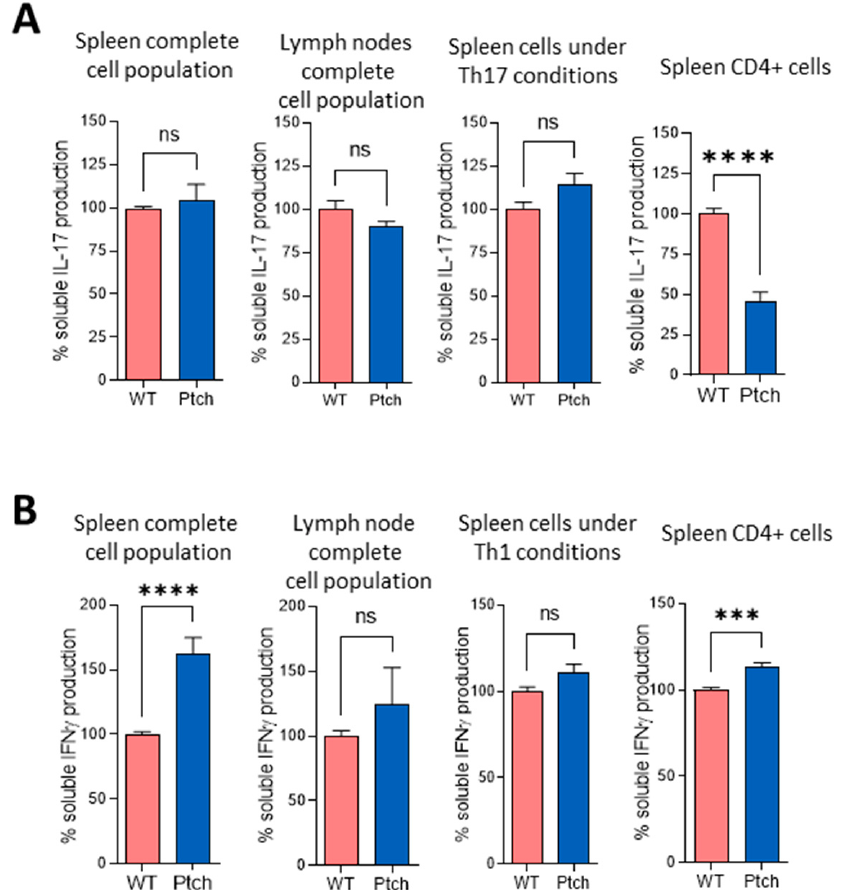
Figure 2. Th1 and Th17 cytokines produced by T lymphocytes from ptch +/ − and wt mice. Total-cell populations from spleen or LN or purified spleen CD4 + cells from ptch +/ − and wt mice were stimulated in vitro by using α CD3/ α CD28. Cells were cultured under non-polarising conditions or under T helper (Th) 17 ( A ) or Th1 ( B ) polarising conditions where indicated. Three-day culture supernatants were subjected to ELISA analysis for IL-17 ( A ) and IFN γ ( B ) determinations. The results are represented as percentages of the values found for wt mice. Data are the mean of five independent experiments in which each sample was assayed in quadruplicate. Each sample corresponds to a pool of spleen or LN cells from four mice. Standard errors of the means are shown. Statistical significance is indicated as *** p < 0.001, **** p < 0.0001 and ns (not significant).